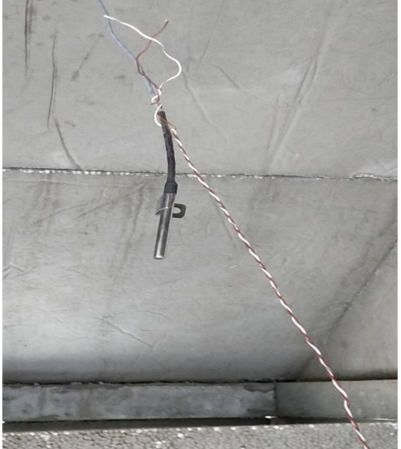
Figure 9. Sensor in prefabricated model house.